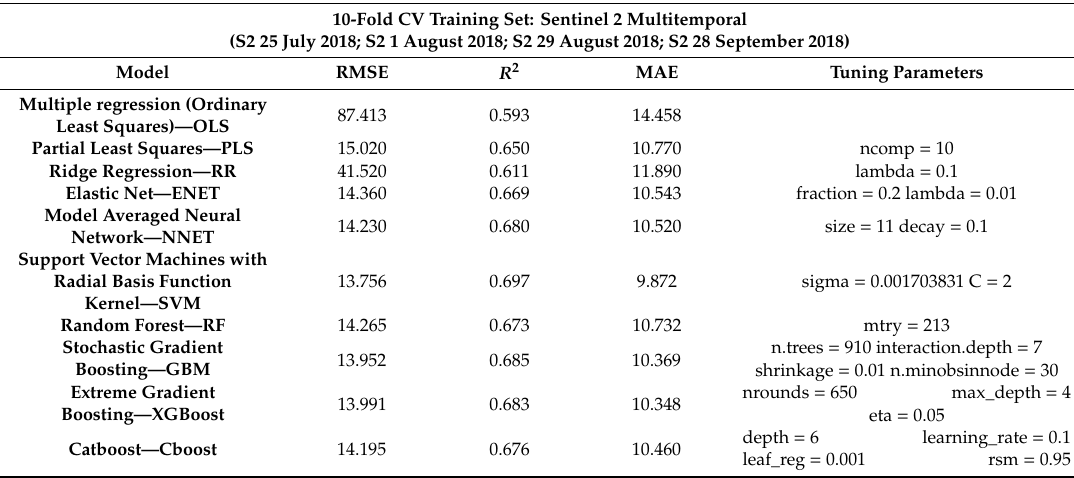
Table 4. The results of 10-fold CV on the training set using multitemporal S-2 images.